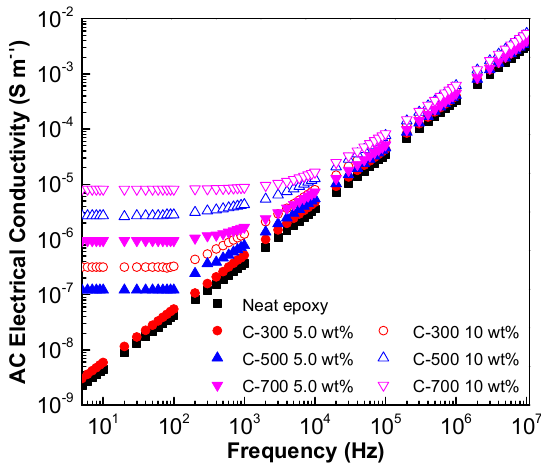
Figure 6. AC electrical conductivity of GNP/epoxy nanocomposites at varying supplied GNP surface area (Note: the surface area of the GNP is the value from the grouping of the GNP (i.e., C-series) specified by the supplier).